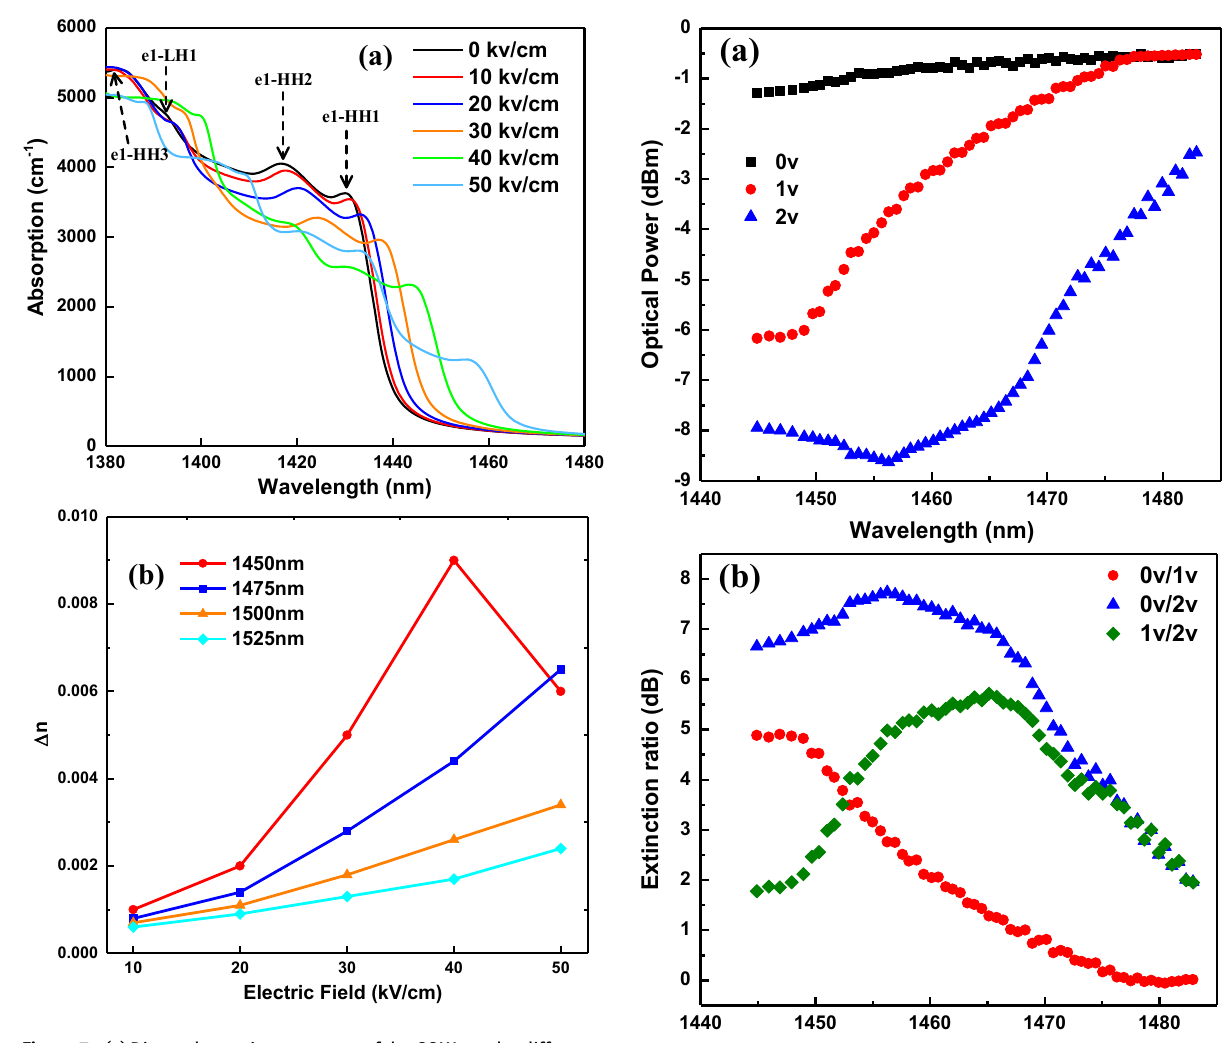
Figure7: (a)DirectabsorptionspectrumoftheCQWsunderdifferent electric fields. (b) Electrorefractive index variation of the CQWs as a function of the electric field for different wavelengths.